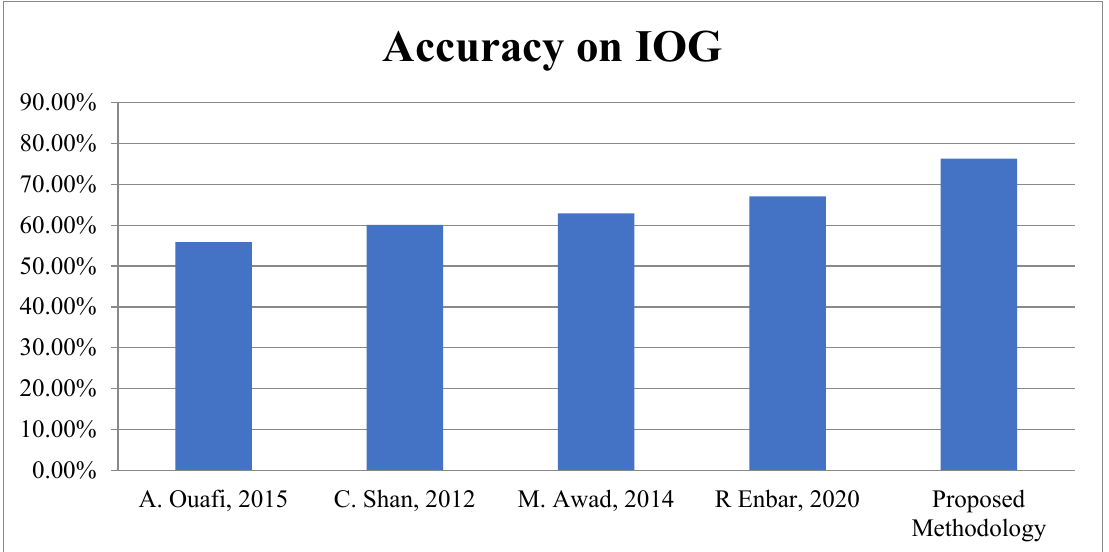
Figure 14. Accuracy Comparison for Age Classification on IOG.